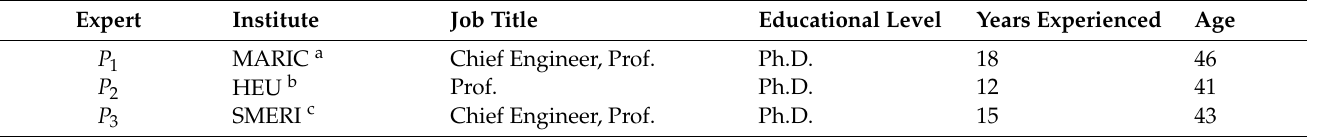
Table 5. Expert profile details.